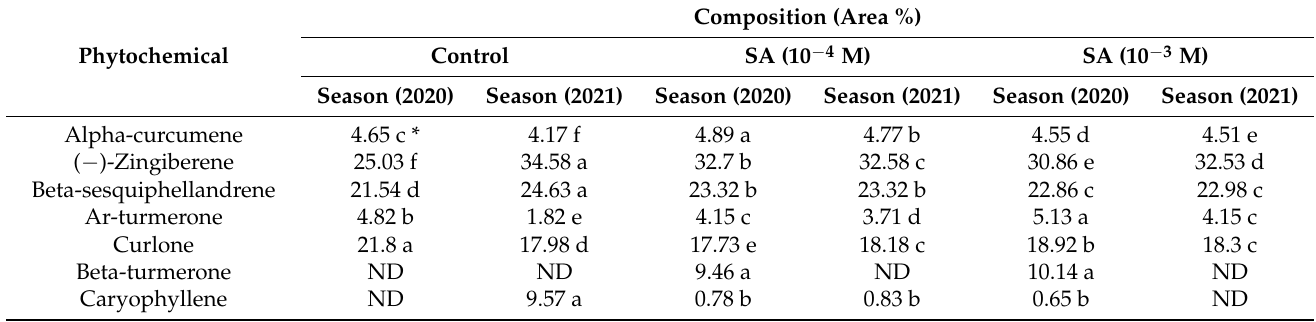
Table 9. Comparison of curcumene, zingiberene, beta-sesquiphellandrene, ar-turmerone, curlone, beta- turmerone, and caryophyllene compositions in the ethanolic rhizome extracts from Curcuma longa plants grown under different concentrations of SA (M). Each mean value was calculated from the measurements obtained from the ethanolic extracts of 3 plantlets. ND: not detectable.